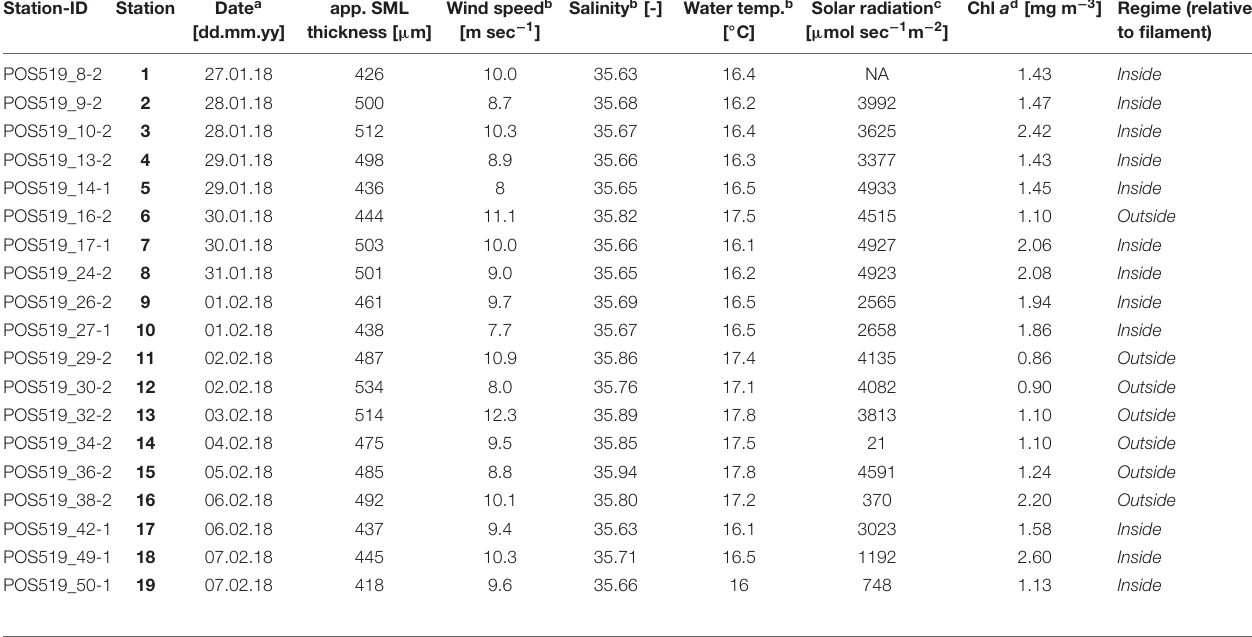
TABLE 1 | Overview of hydrological and meteorological conditions.